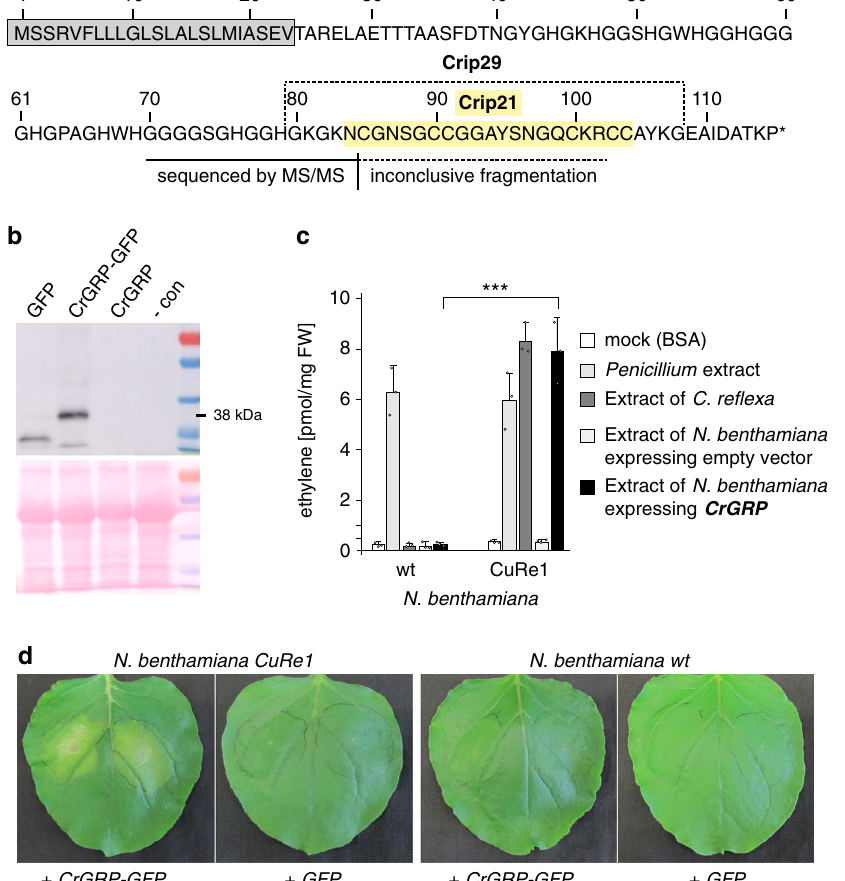
Fig. 2 The C. re fl exa Glycine-rich protein (CrGRP) triggers CuRe1-dependent defense responses. a Protein sequence of the identi fi ed CrGRP; the peptide isolated from C. re fl exa extracts was sequenced de novo by mass spectrometry and is indicated starting at aa-position 70, dashed line indicates the peptide part which could not be sequenced by MS/MS; Crip21 motif highlighted in yellow. b heterologous expression of CrGRP gene in N. benthamiana leaves; WB shows a c-terminally GFP-tagged CrGRP. c Ethylene response in leaves of wt or CuRe1 -expressing N. benthamiana . Plants were treated with extracted CrGRP after heterologous expression shown in b. Bovine serum albumine (BSA; 0.01 mg/ml) buffered in 25 mM MES (pH 5.7) was added as mock control; Penicillium extract (0.05 mg/ml) served as positive control 31 . FW, fresh weight; ethylene measurements show means of three technical replicates; dots indicate single data points; error bars denote SD, asterisks denote student ’ s t-test, p ≤ 0.0003; representative graphs are shown; experiments were repeated more than three times. d Expression of CrGRP-GFP in leaves of wildtype (wt) and transgenic CuRe1 -expressing N. benthamiana plants. GFP alone served as negative control; pictures 5 days after